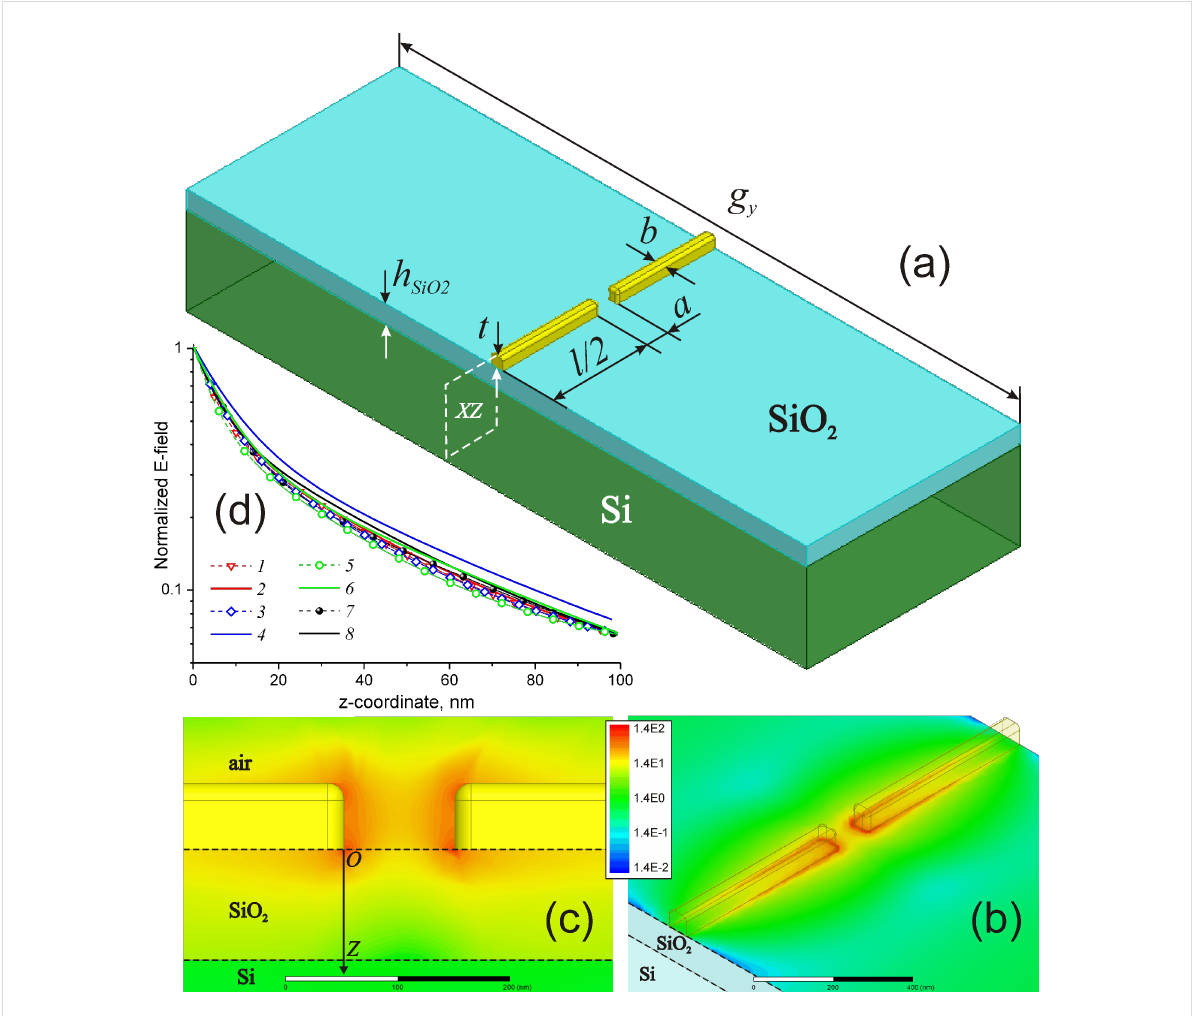
Figure 5: a) Structure geometry definition for the nanoantenna array (the unit cell is shown). b) Example of the distribution for the normalized electric field magnitude over SiO 2 surface for the nanoantenna length l = 1100 nm. c) Similar E -field distribution referred to the vertical plane (XY) cutting the nanoantenna in the middle. d) Functional behavior of the near field decay along the OZ axis at the longitudinal LSPR frequency calculated for differ- ent nanoantenna lengths: 1: l = 500 nm, h SiO2 = 0 nm; 2: l = 500 nm, h SiO2 = 100 nm; 3: l = 700 nm, h SiO2 = 0 nm; 4: l = 700 nm, h SiO2 = 100 nm; 5: l = 900 nm, h SiO2 = 0 nm; 6: l = 900 nm, h SiO2 = 100 nm; 7: l = 1100 nm, h SiO2 = 0 nm; 8: l = 1100 nm, h SiO2 = 100 nm.